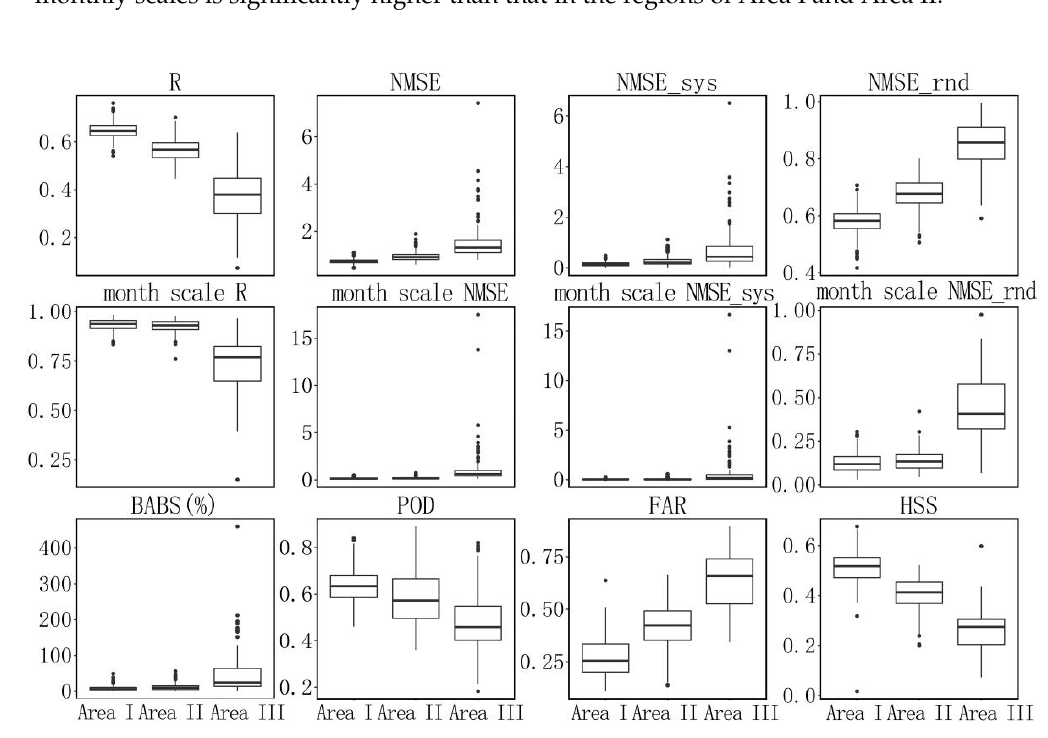
Figure 10. Distribution of the accuracy indicators of the three accuracy level areas. The box plots display the statistical accuracy indicators at the daily and monthly scales. The upper and lower edges of the box indicate the upper and lower quartiles (75% and 25%, respectively); the solid line in the box indicates the median; the points indicate the outliers.